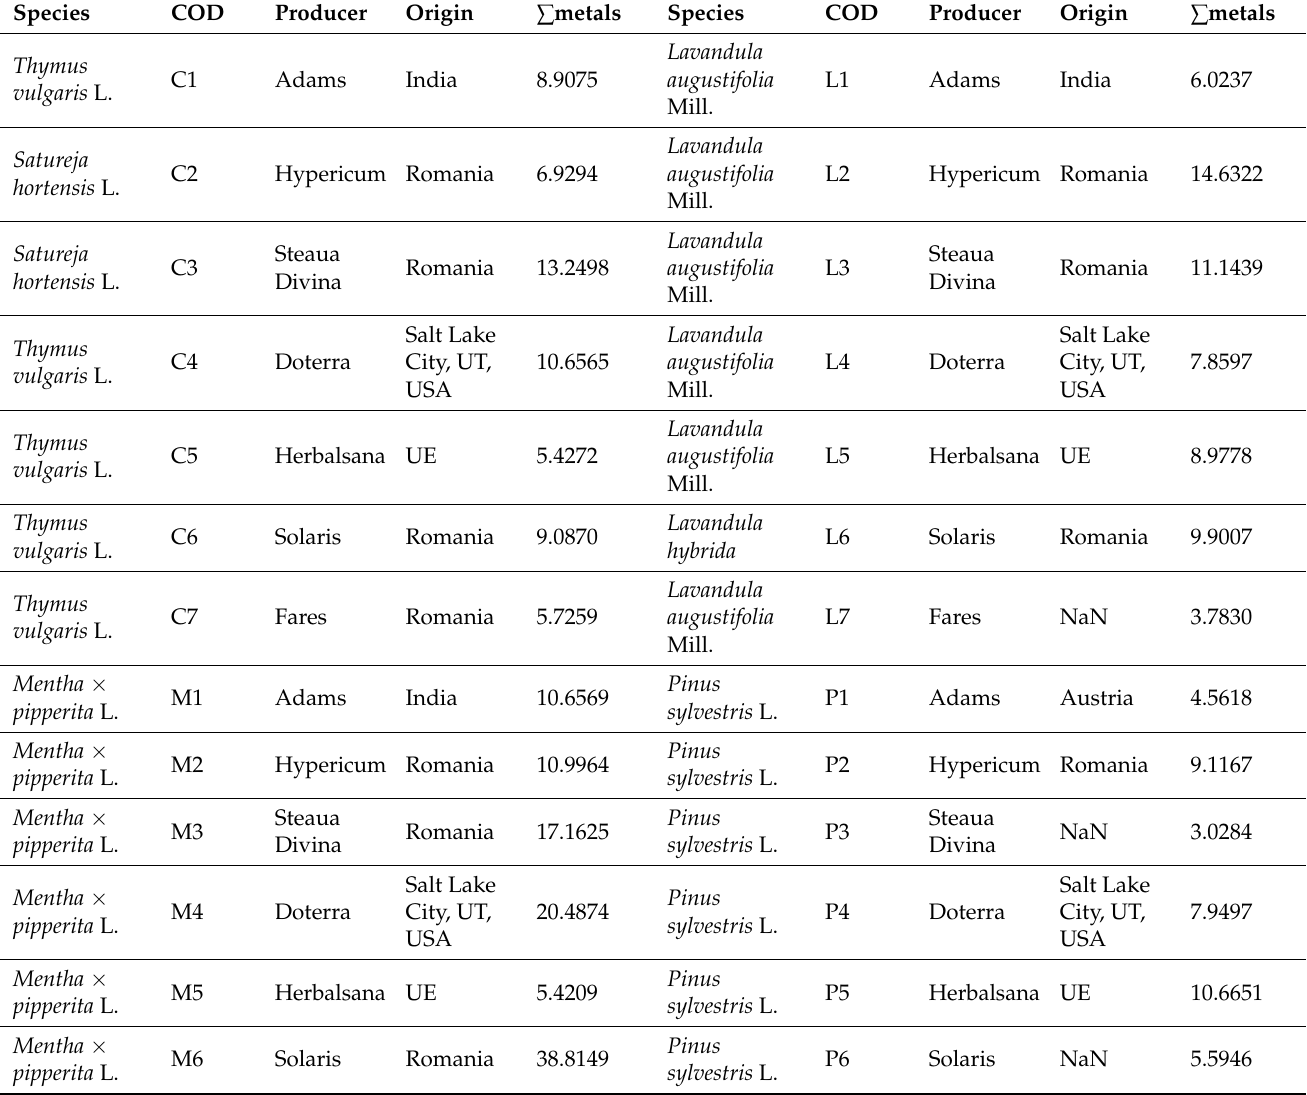
Table 1. Selected samples with linked